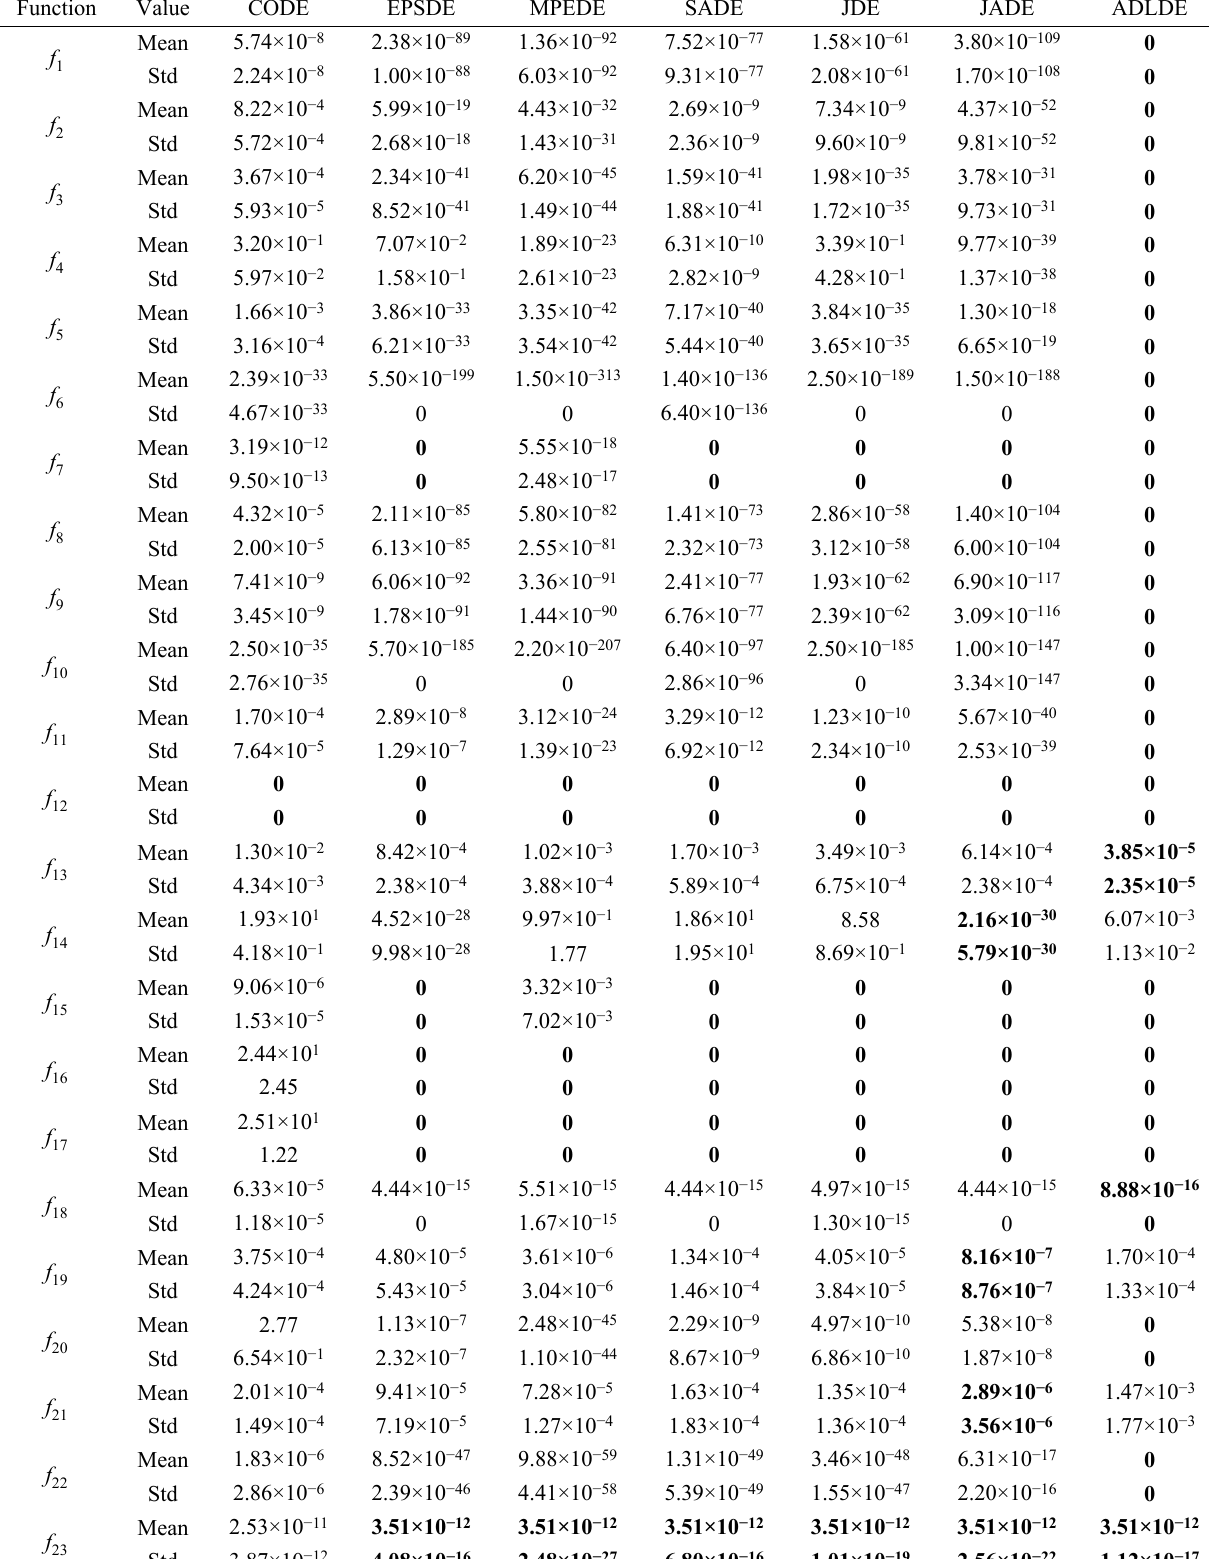
Table A3 Function error values of benchmark functions when D =